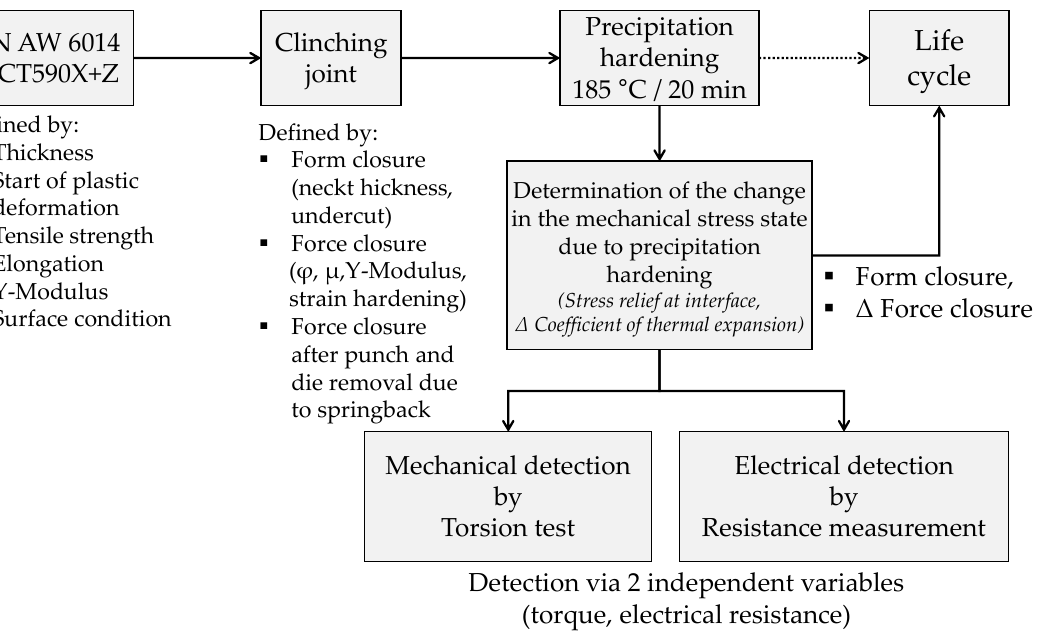
Figure 8. Factors influencing the clinch connection along the process chain.